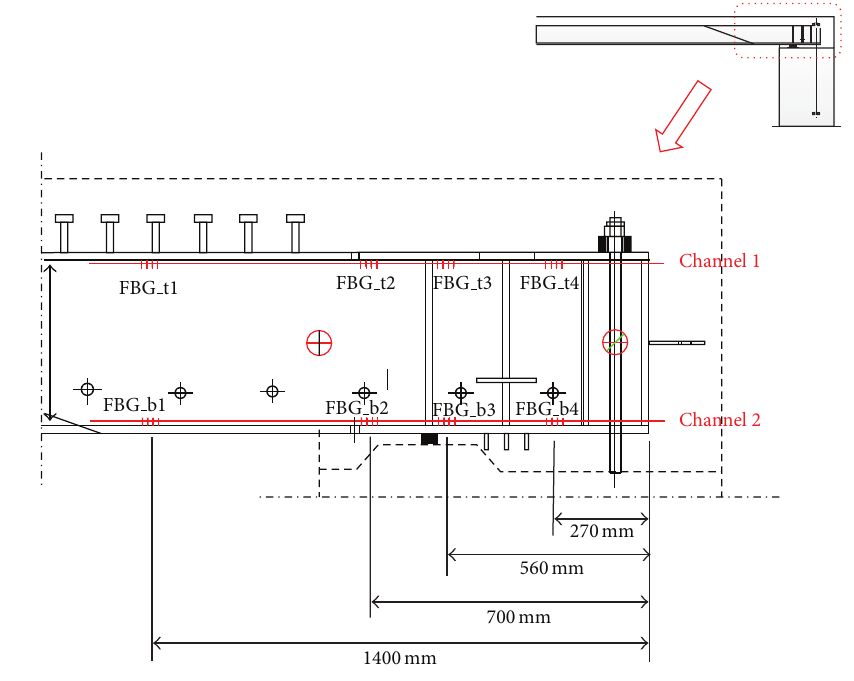
Figure 4: Layout of FBG sensor arrays at joint